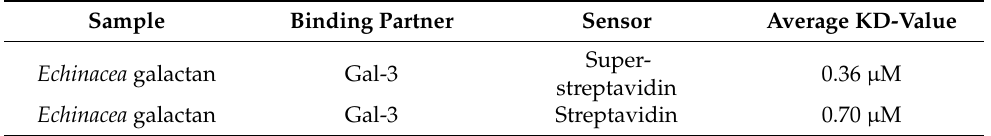
Table 3. Binding parameters of Gal-3 with Echinacea galactan determined by BLI. Average values are calculated from two independent experimental